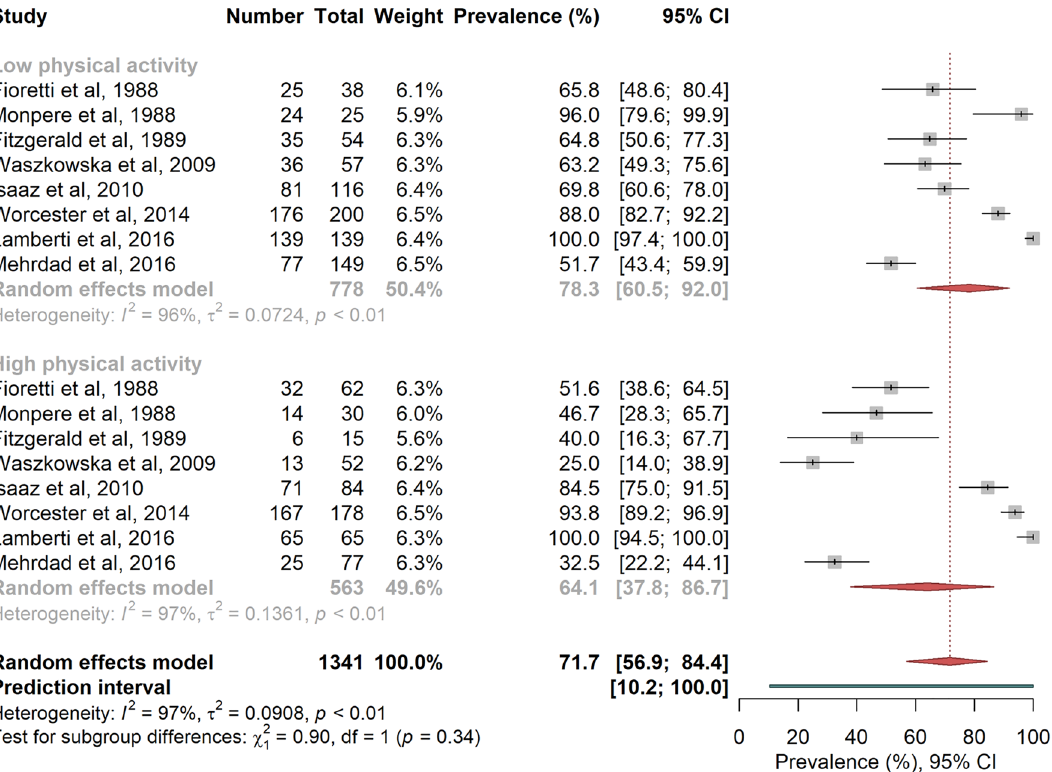
Figure 5. Random-effects meta-analysis of return-to-work prevalence according to occupational physical activity. The squares and horizontal lines correspond to the study-specific prevalence and 95% CIs. Proportionally sized boxes represent the weight of each study. The diamond represents the pooled prevalence and 95% CI of the overall population. The horizontal thick line corresponds to the 95% prediction